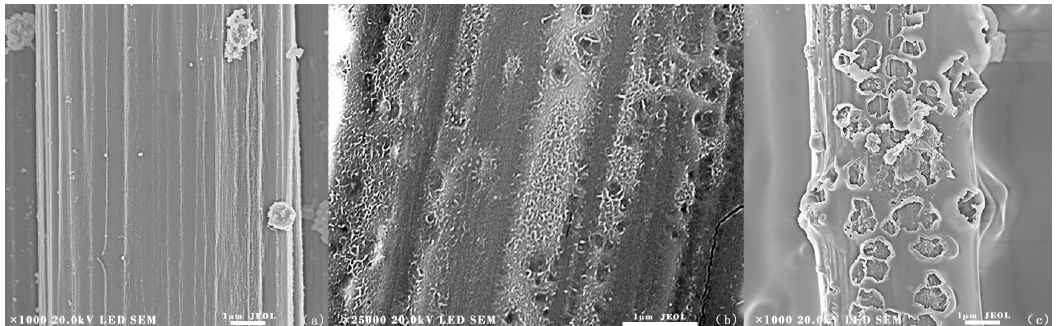
Figure 5. SEM micrograph of the surface of ( a ) SiC/SiO 2 coated CF(800 °C,15 min); ( b ) SiC/SiO 2 coated CF(1000 °C,15 min); and, ( c ) SiC/SiO 2 coated CF(1400 °C,15 min).